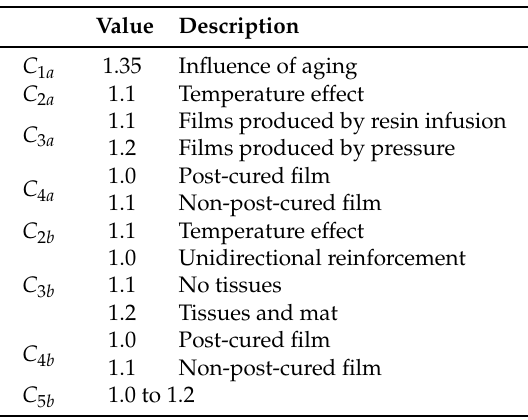
Table 2. Values of safety factors